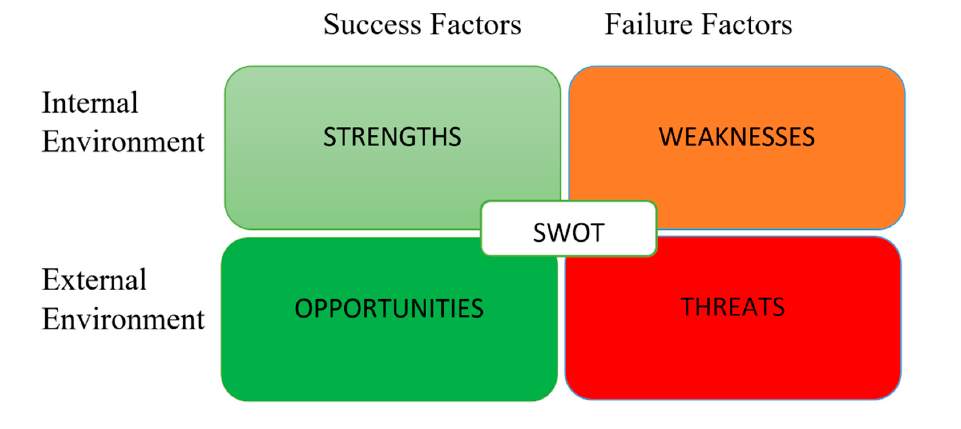
Figure 3. SWOT matrix structure: